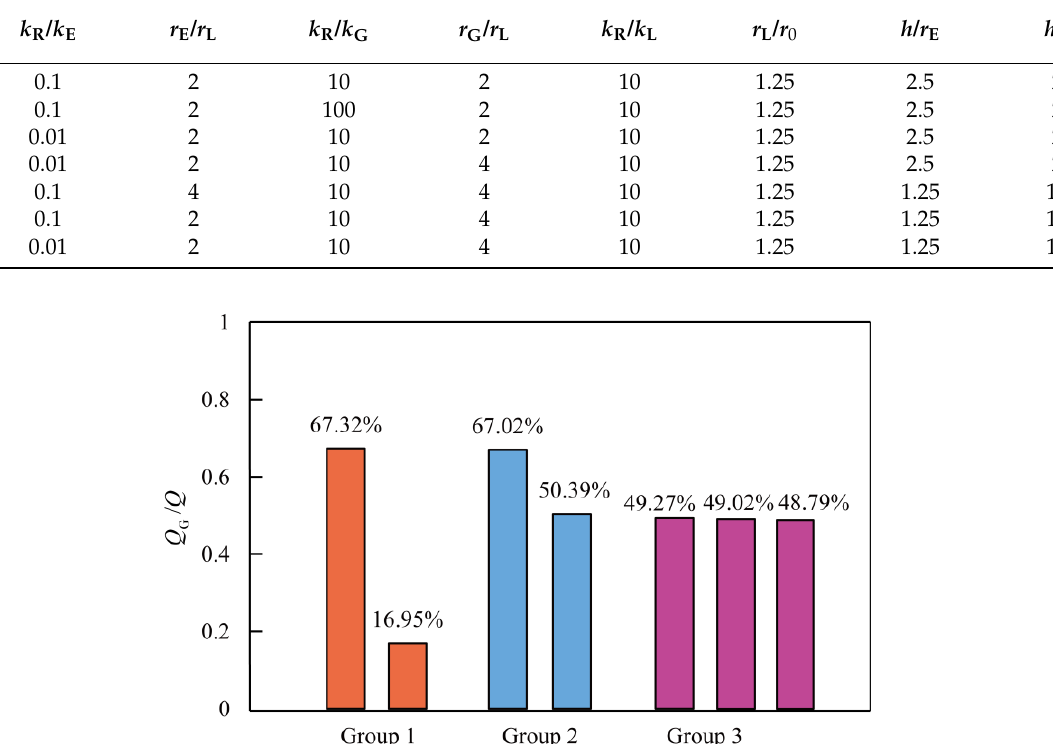
/ Q Q values with different grouting parameters. Figure 10. Q G / Q values with different grouting Figure 10. G